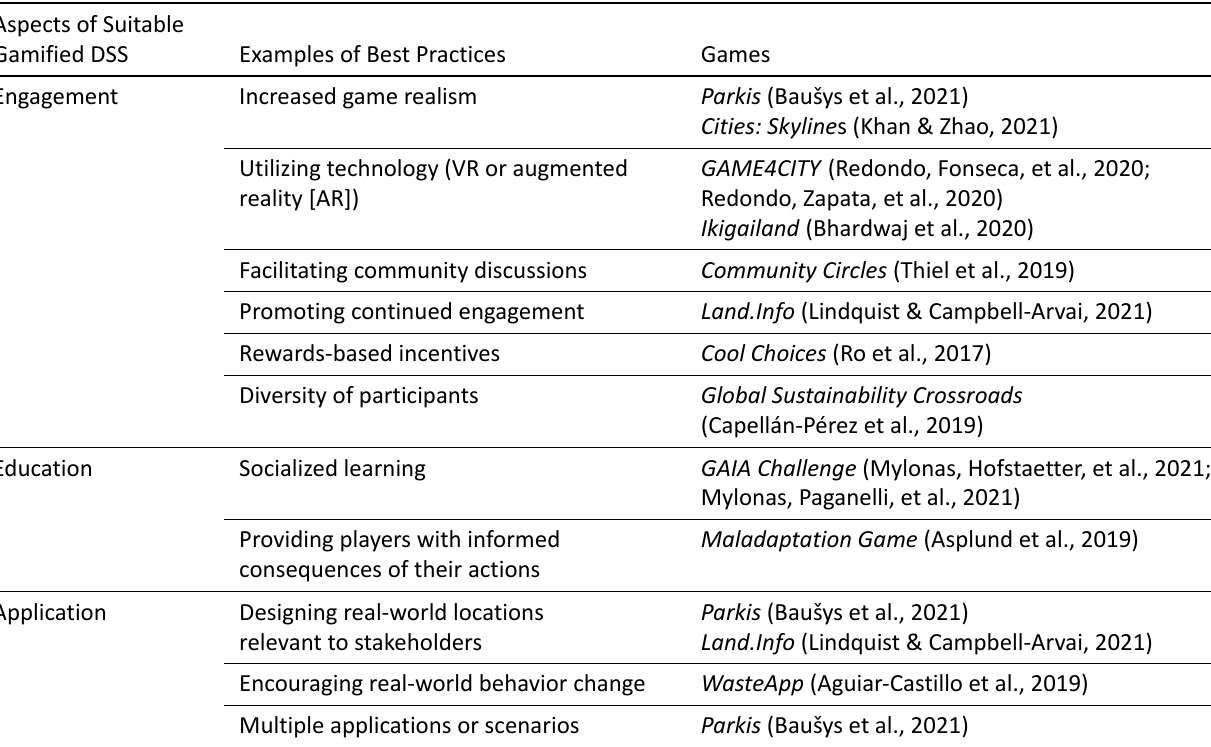
Table 1. Examples of best practices from reviewed